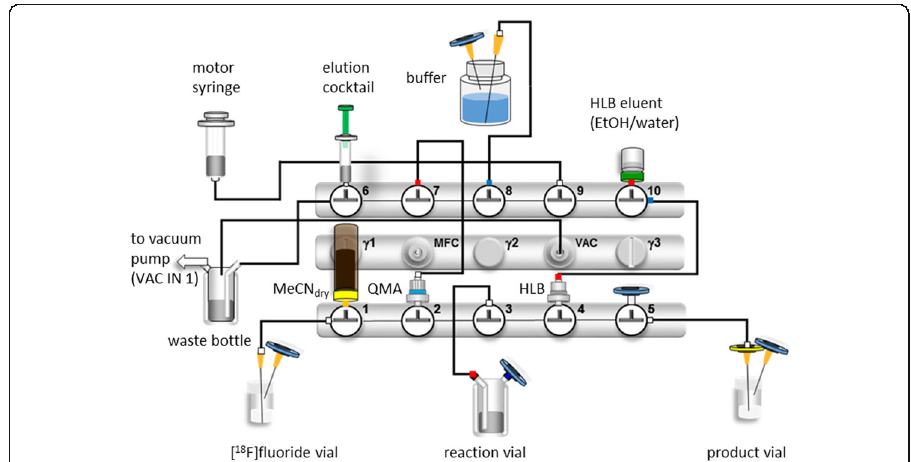
Fig. 3 Design of the cassette-based automated production of [ 18 F]Ga-rhPSMA-7/ -7.3. MFC: mass flow controller; VAC: negative pressure sensor; VAC IN: to built-in vacuum pump; [ 18 F]fluoride vial: collecting vessel for irradiated target water form cyclotron. The valve numbers (1 – 10) are indicated in the text as